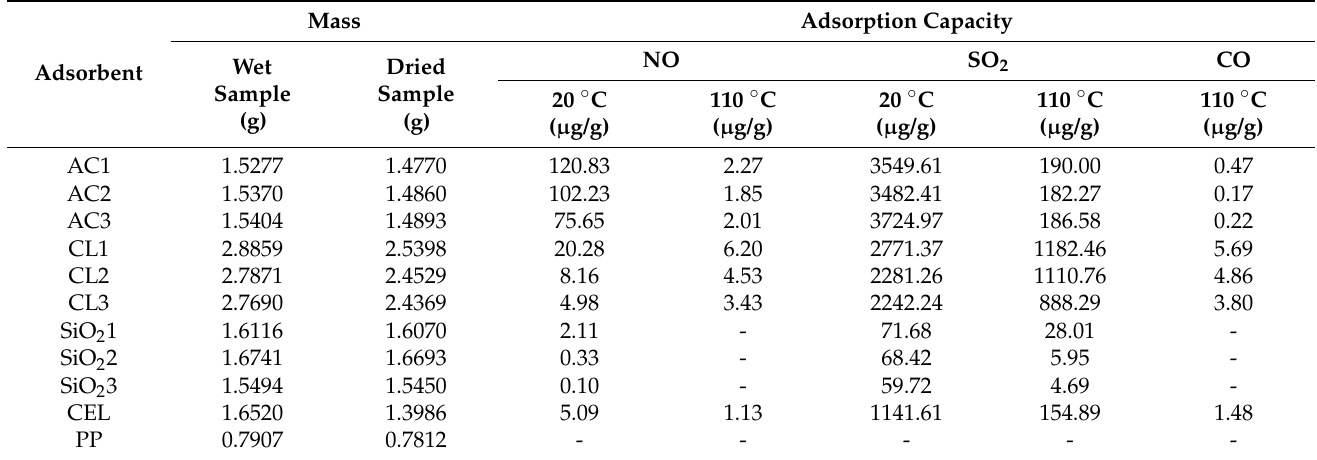
Table 3. The adsorbents in the wet and dried state and their adsorption capacities for different molecules (NO, SO 2 , CO) at different adsorbent temperatures (20 and 110 ◦ C).